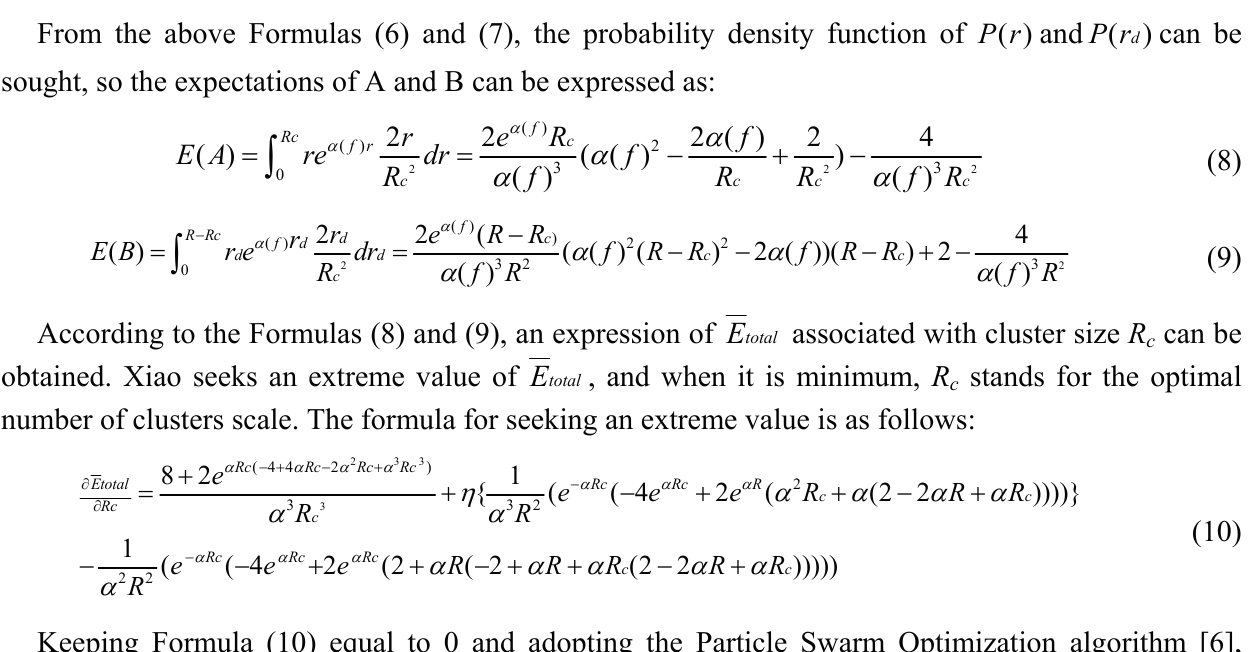
Table 1. Solutions of R